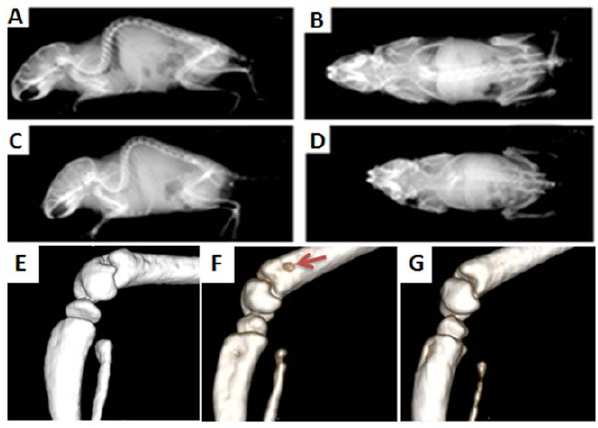
Figure 6. MicroCT andhind limb bone imaging inVCP R155H/R155H and WT mice. MicroCT images in (A,B) WT and (C,D) homozygote VCP R155H/R155H animals. Bone images of the (E) left hind limb bone in WT and (F,G) left and right hind limb bones in VCP R155H/R155H animals showing a Paget-like lesion (shown by red arrow), respectively.